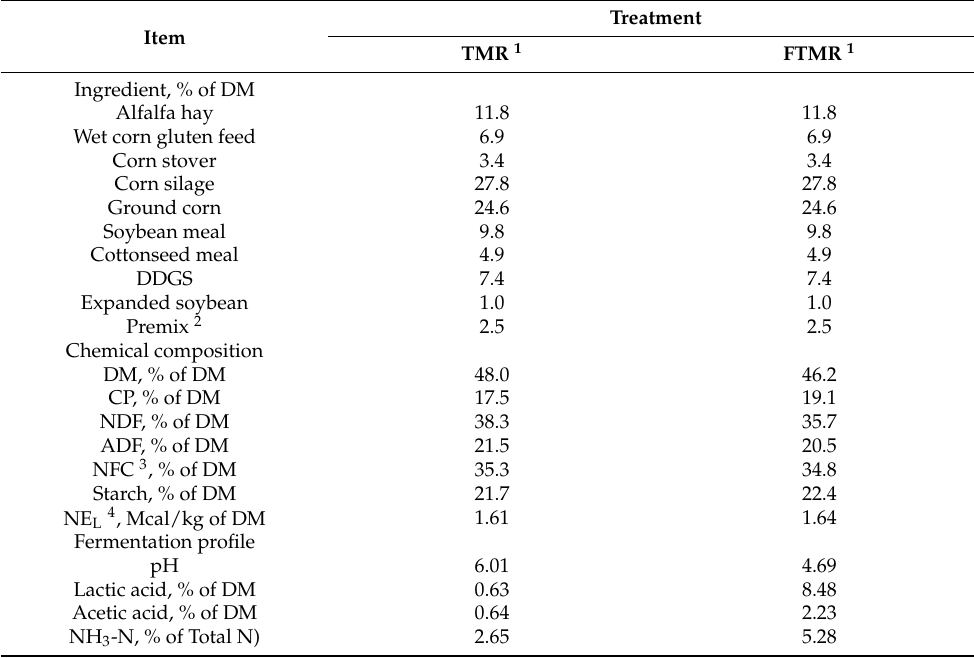
Table 1. Ingredients and chemical composition of two treatment diets. Item Ingredient, % of DM Alfalfa